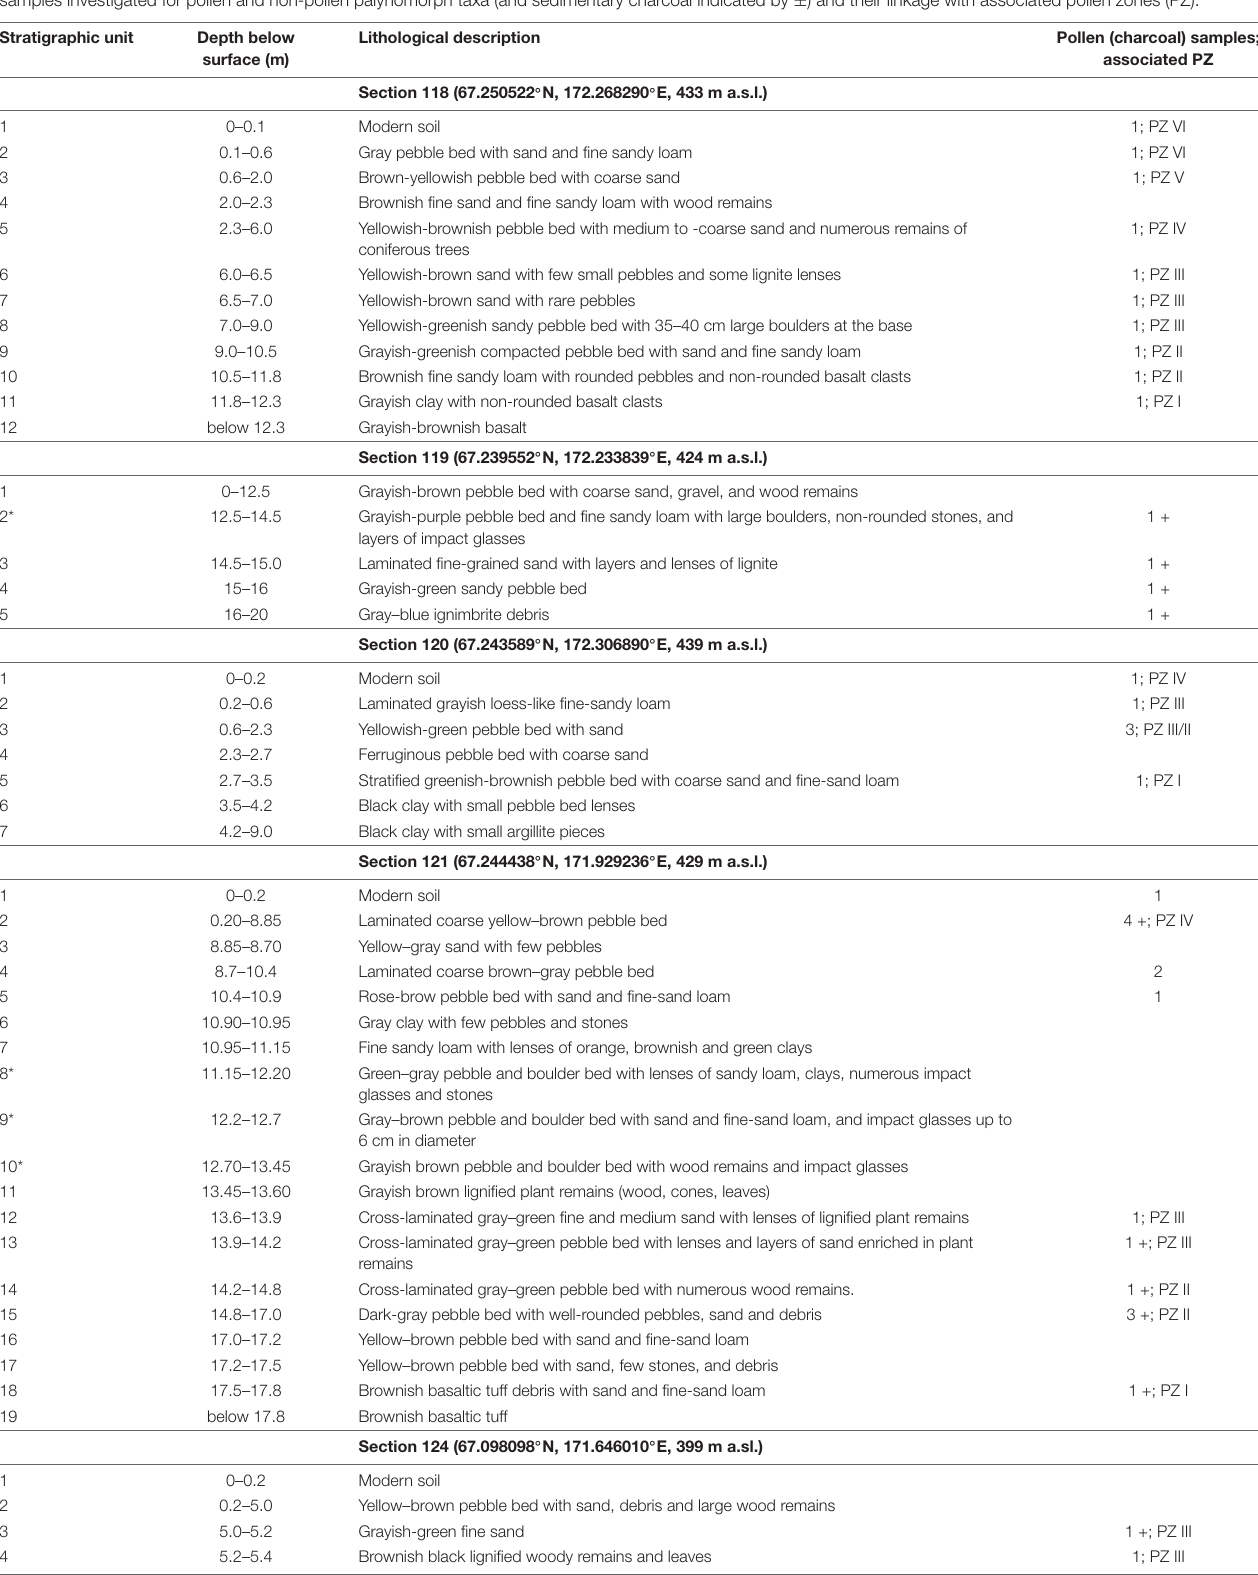
TABLE 1 | Stratigraphy of fluvial terrace sections downstream of Lake El’gygytgyn (“chaotic horizons” marked with *) with their lithological descriptions, the number of samples investigated for pollen and non-pollen palynomorph taxa (and sedimentary charcoal indicated by ± ) and their linkage with associated pollen zones (PZ). Stratigraphic